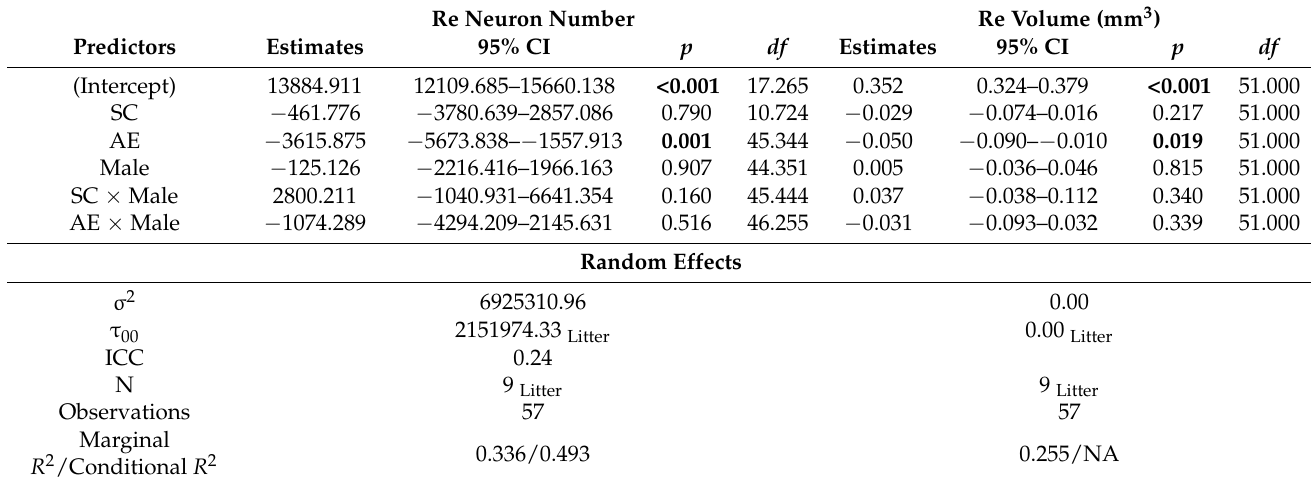
Figure 3. High-dose alcohol exposure (AE) during the brain growth spurt (BGS) results in reduced number (#) of neurons in thalamic nucleus reuniens (Re) and a reduction in the total volume of Re. The AE postnatal treatment group had significantly lower number of neurons in Re (left) and significantly reduced total volume of Re (right), consistent with past studies [21,22]. Individual data points represent one animal and are superimposed over bars representing mean within that postnatal treatment. Data include both male and female animals, which are not differentiated due to the lack of sex effects. Sample sizes are given in parentheses below each treatment group. * p ≤ 0.050, ** p ≤ 0.010. For exact statistical values, see Table 3. Table 3. Regression table for Re neuron number and Re volume, as visualized in Figure 2 and quantified in Figure 3. Table was generated using the “tab_model” function (df method = Satterthwaite) from the “sjPlot” package on “lmer” objects from the “lmerTest” package. Significant predictors (i.e., p ≤ 0.050) are indicated by bold p